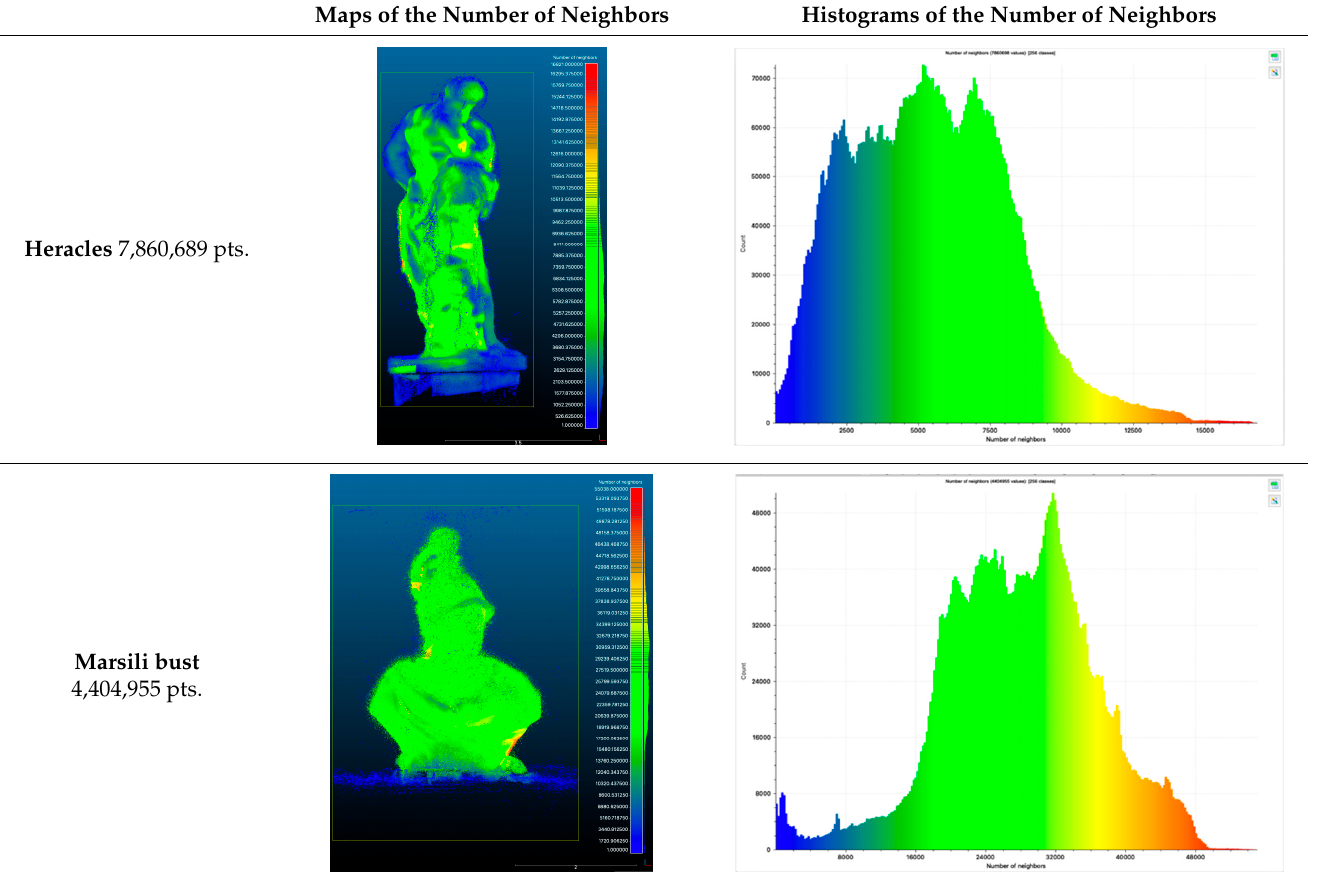
Heracles 7,860,689 pts.